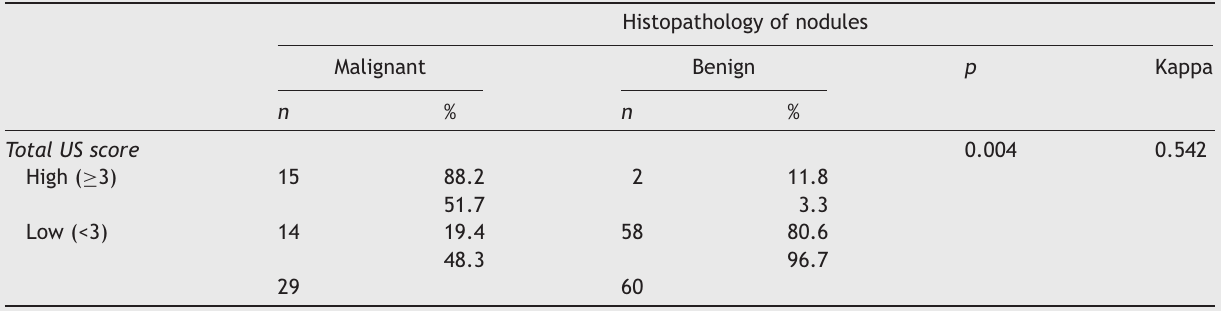
Distribution of malignant and benign nodules in the low and high score